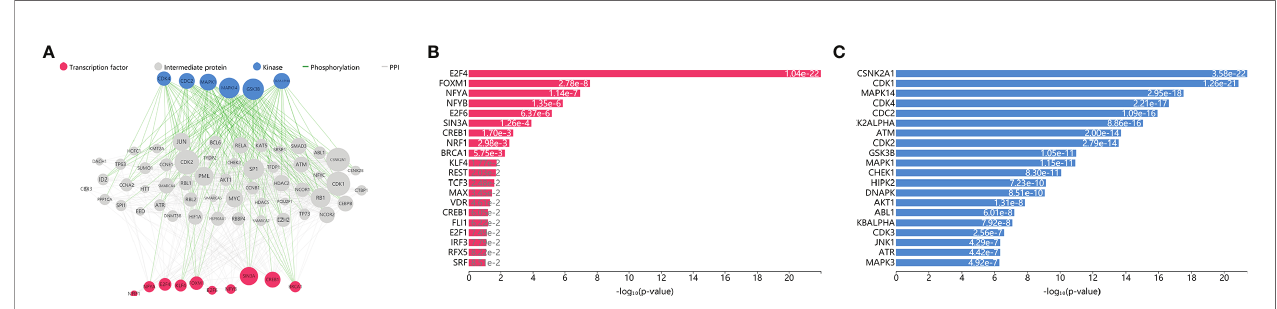
FIGURE 8 | Upstream regulatory network prediction according to the downregulated DEGs. (A) Regulatory network diagram according to the prediction of the downregulated DEGs. Nodes ’ size is scaled proportional to the corresponding degree. (B) Kinases and (C) transcription factors according to the predictions of the downregulated DEGs. DEGs, differentially